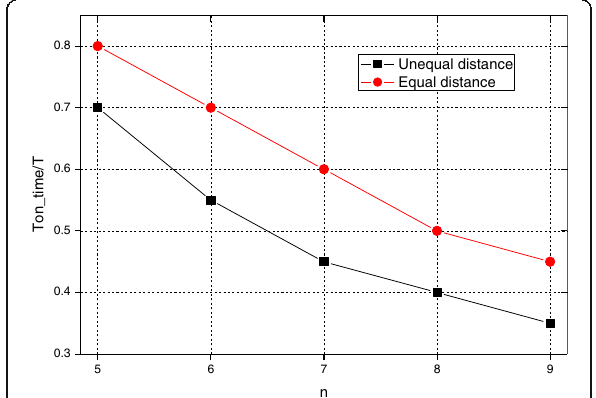
Fig. 10 The optimal duty cycle under UDNP and EDNP (MQAM)